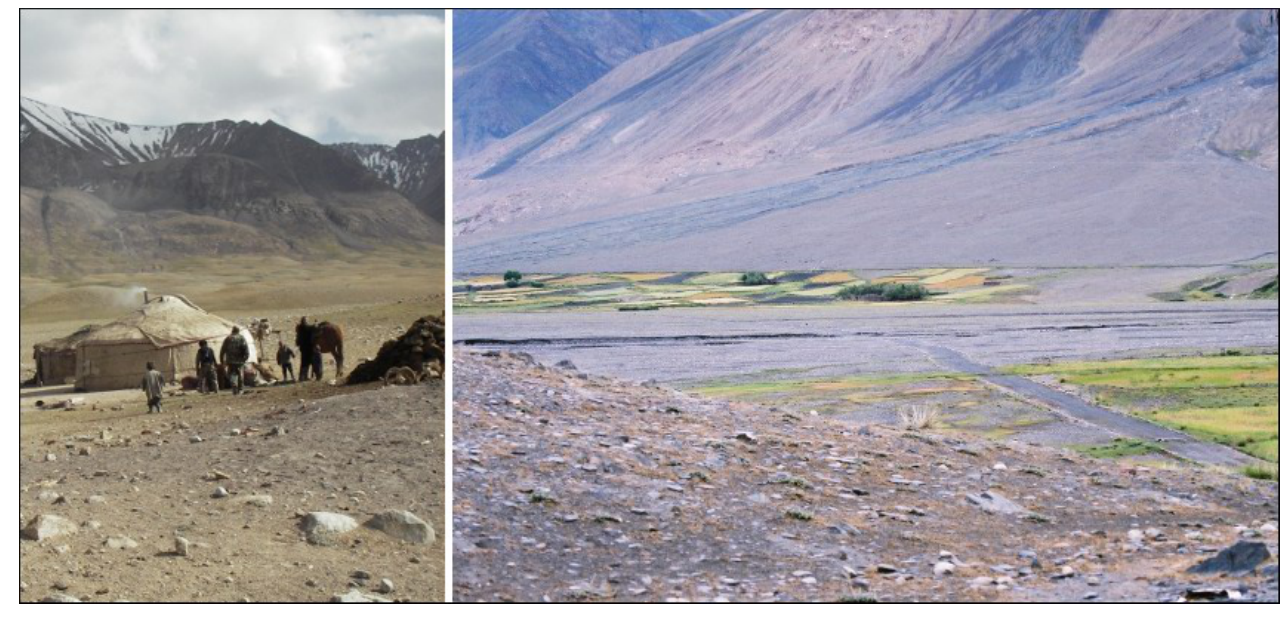
Fig. 3 . Kyrgyz settlement of Tashbulaq and Wakhi village of